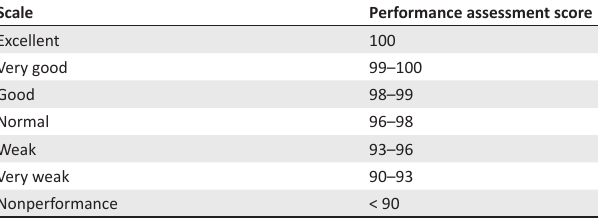
TABLE 2: Data classification of performance assessment score. Scale